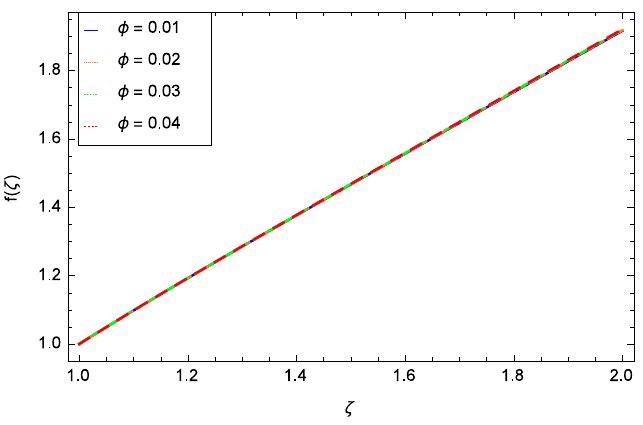
Figure 5. Non-dimensional velocity f ( ζ ) sketch for h = − 1.10, β 1 = 1.70, M = 0.10, Re = 0.70, Pr = 6.80 and various values of φ (CuO-H 2 O).